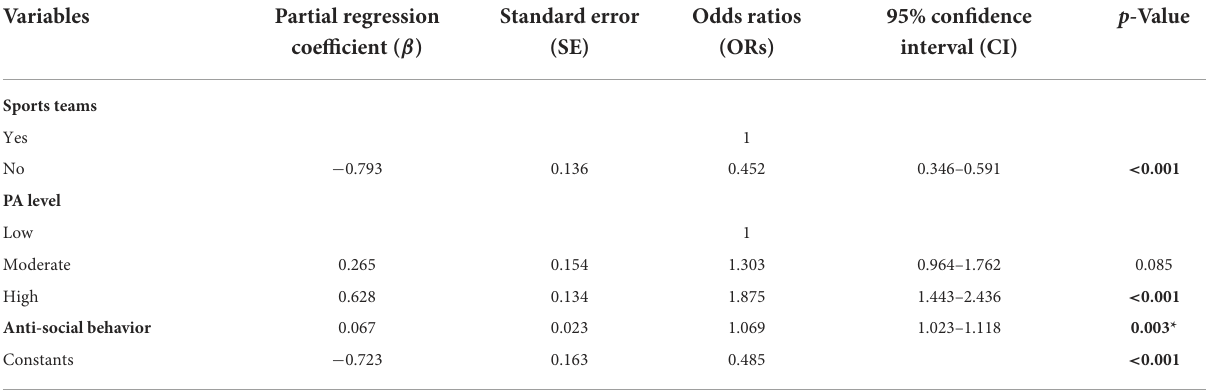
TABLE 4 Risk factors for PARI amongst males.